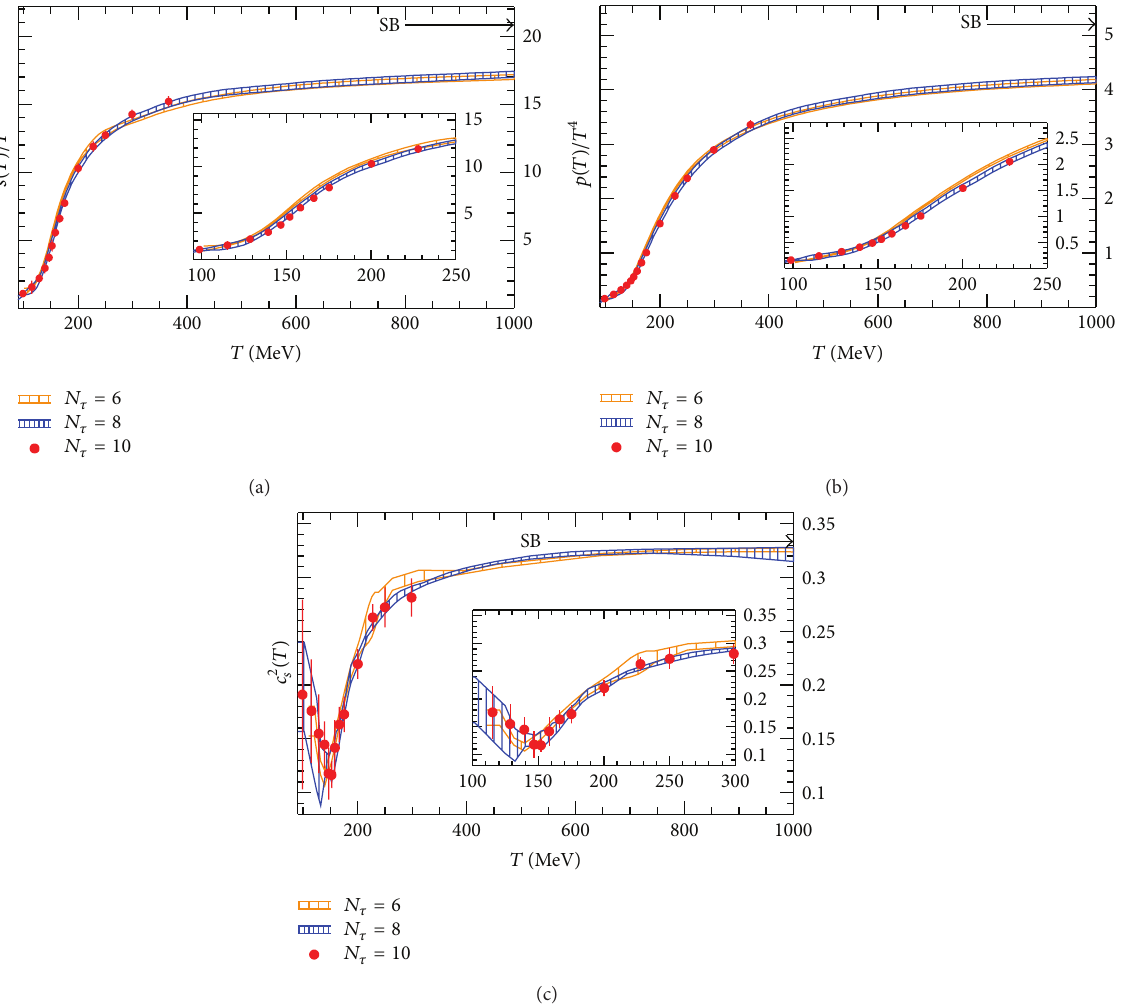
Figure 8: The entropy density, pressure, and the speed of sound for the stout-smeared fermions as a function of temperature, from